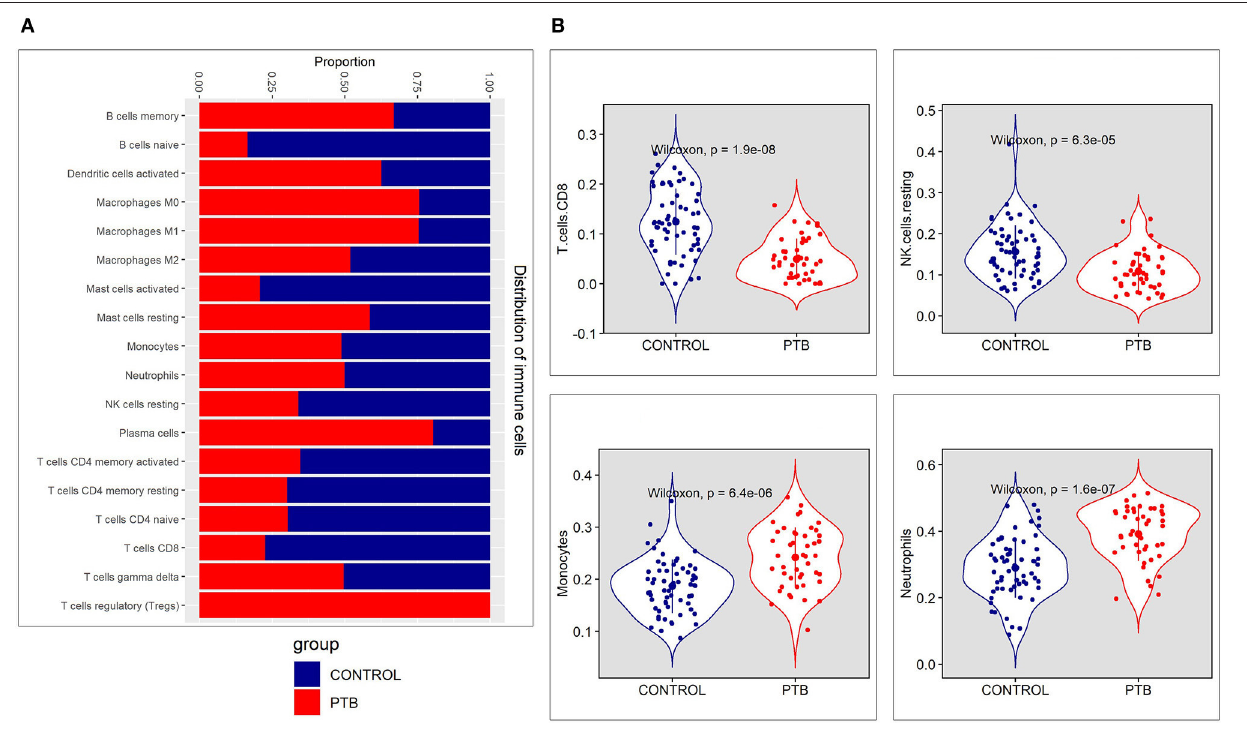
FIGURE 2 | The immune cell proportion landscape between pulmonary TB (PTB) and controls. (A) The relative proportion of immune cell subpopulations in GSE83456 dataset. (B) The difference of immune infiltration between PTB and normal controls (the control group was marked in blue color and the PTB group was marked in red color. P < 0.05 were considered as statistically